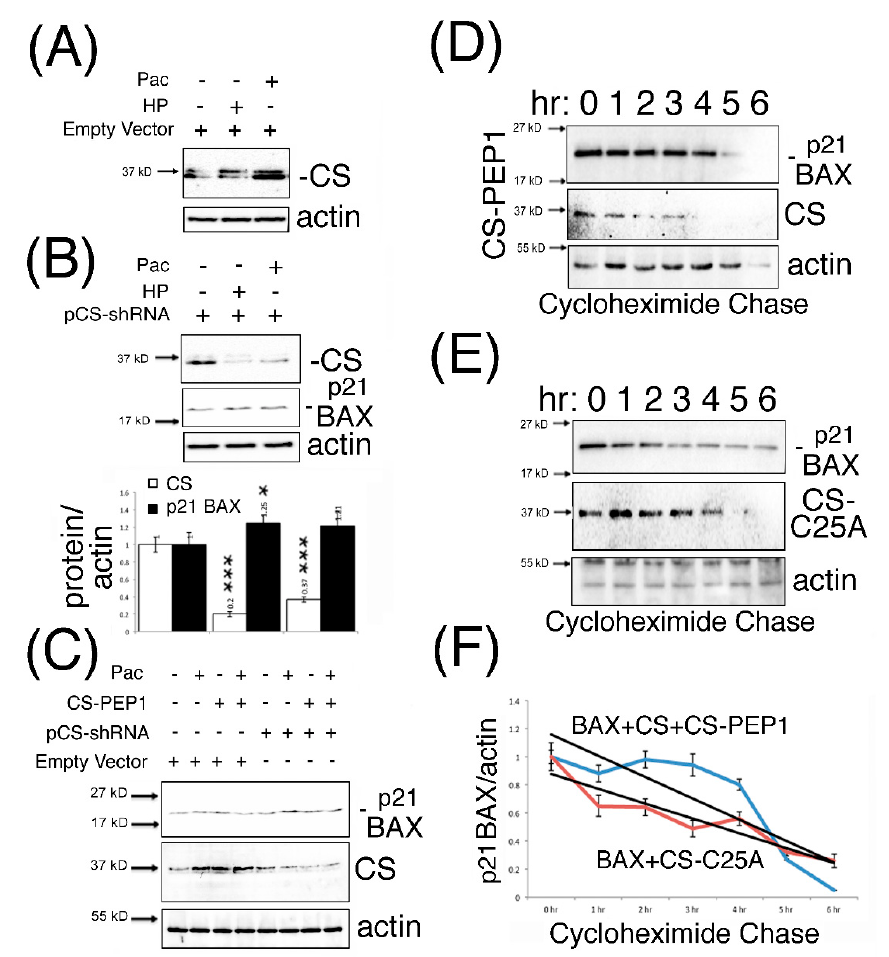
Figure 5. p21 BAX protein is stabilized in the presence of CS-shRNA expression, with or without CS-PEP1 co-treatment in HEK293 cells. HEK293 cells were transfected with 3 µ g of empty vector (pTER, Panel A ) or pCS-shRNA (Panel B ) for 24 h, stimulated with Pac (5 µ g/mL) or HP (1 µ M) for a further 24 h and equal volumes of WCLs analyzed for endogenous CS (white bars) and p21 BAX (black bars) expression using Western blotting. Endogenous p21 BAX, CS and actin levels were detected from equal volumes of HEK293 soluble cell lysates by Western blotting, following 24 h of pCS-shRNA transfection (3 µ g) and Pac (5 µ g/mL) with CS-PEP1 (10 µ M) co-stimulation (Panel C ) for a further 24 hr. HEK293 cells co-transfected with pBAX-HA and pCS-FLAG or pBAX-HA and pCS-C25A-FLAG for 6 hr were stimulated with carrier or 10 µ M CS-PEP1 for 18 h and treated with 20 µ M cycloheximide. After 1 h, at the time points indicated, cells were lysed and equal volumes of soluble WCLs analyzed for p21 BAX, CS and actin expression using Western blotting (Panels D , E ). Expression levels for p21 BAX were quantified, standardized for actin and expressed in relation to levels seen at T = 0 h. BAX and CS co-expression in the presence of CS-PEP1 stimulation (blue curve) and p21 BAX with CS-C25A co-expression (red curve) are indicated as trend lines (black curves, Panel 5 F ). Quantified data are presented as the mean ± SEM and its significance (where p < 0.05) determined, using a two-way Student’s t -test (* p < 0.05 and *** p <